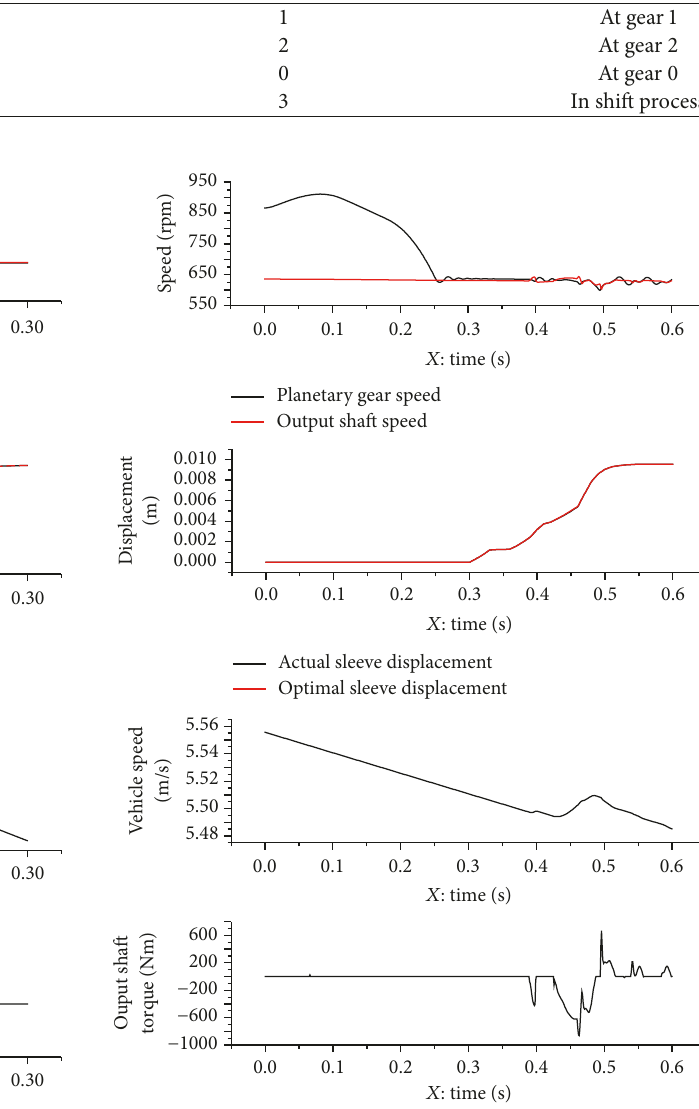
Figure 17: The simulation architecture diagram of the proposed